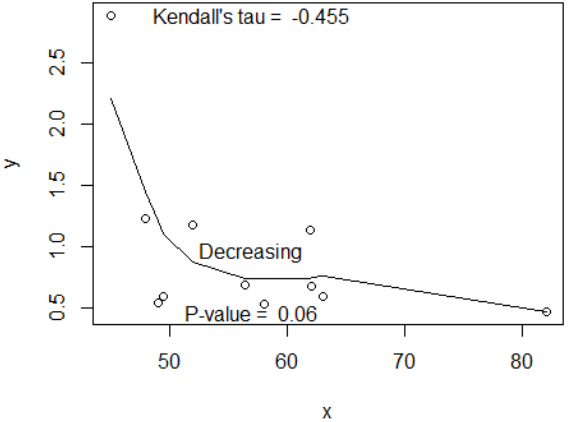
Figure 2. The LOWLESS plot based on the estimates ( y ) and the proportions of males ( x ) from the COVID-19 data with 11 studies. Shown are Kendall’s tau and the test of no association between x and y .